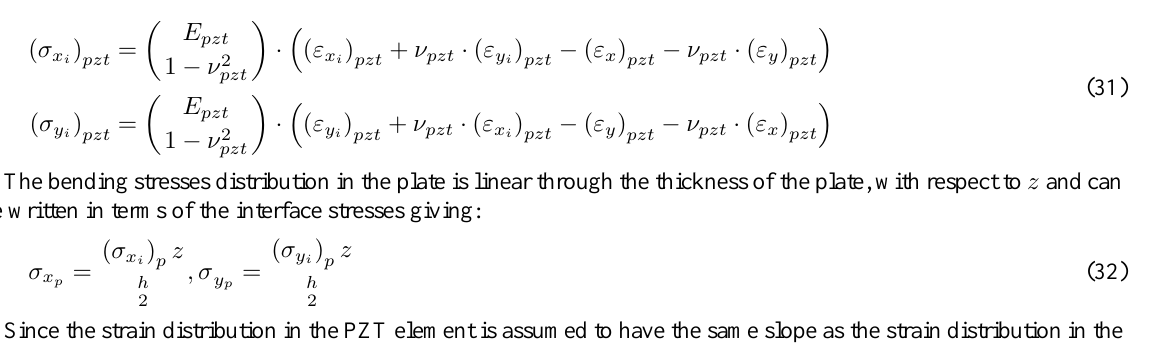
Fig. 12. Voltage time history due to center actuation by a wide PZT patch; (a) array voltage for 2 ms, (b) array voltage for 0.2